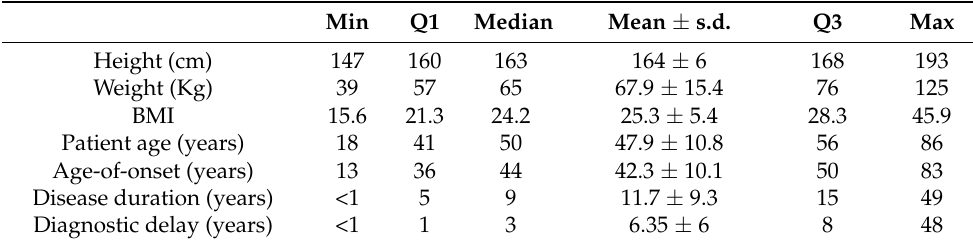
Table 2. Clinical characteristics of participants (n =